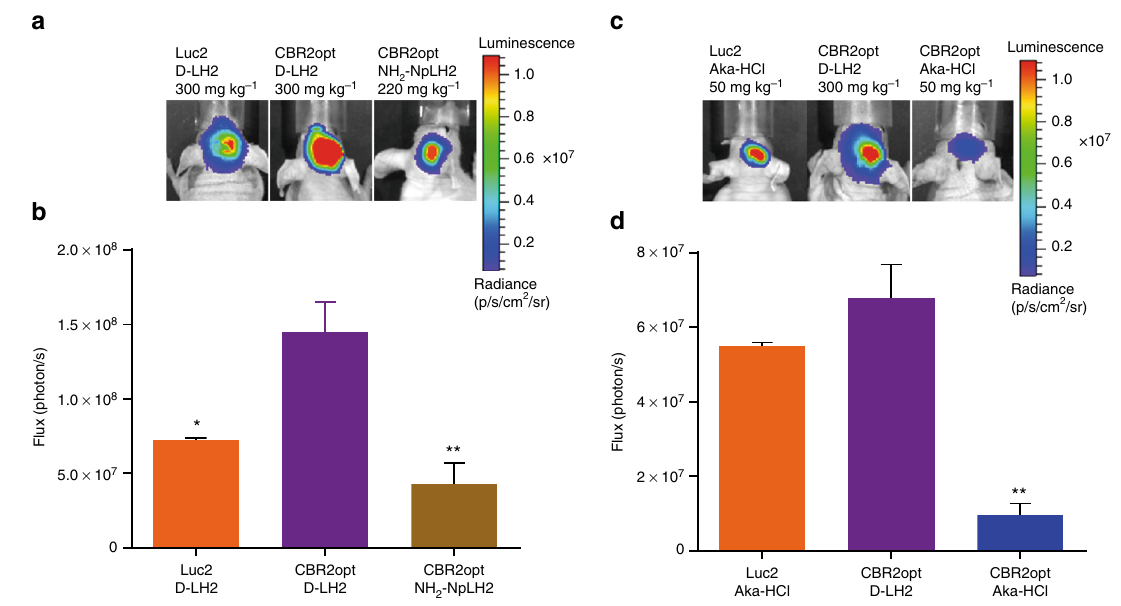
Fig. 4 Comparison between CBR2opt and Luc2 utilizing either D-LH2 or Aka-HCl for imaging mouse brain. a Images of representative mice after intracranial implantation of 1 × 10 5 HEK-EF1-Luc2-T2A-copGFP or HEK-EF1-CBR2opt-T2A-copGFP cells and intravenous injection of D-LH2 (300 mg kg − 1 ) or NH 2 -NpLH2 (220 mg kg − 1 ) ( n = 4). b Quanti fi cation of photon fl ux (photon per s) with an exposure time of 30 s at the peak of bioluminescence emission (4 – 7 min after substrate injection) (* p < 0.05; ** p < 0.01 compared to CBR2opt/D-LH2). c Images of representative mice after intracranial implantation of cells and intravenous injection of either D-LH2 (300 mg kg − 1 ) or Aka-HCl (50 mg kg − 1 ) ( n = 3). d Quanti fi cation of fl ux (photon/s) with an exposure time of 30 s (** p < 0.01 compared to CBR2opt/D-LH2). Error bars represent